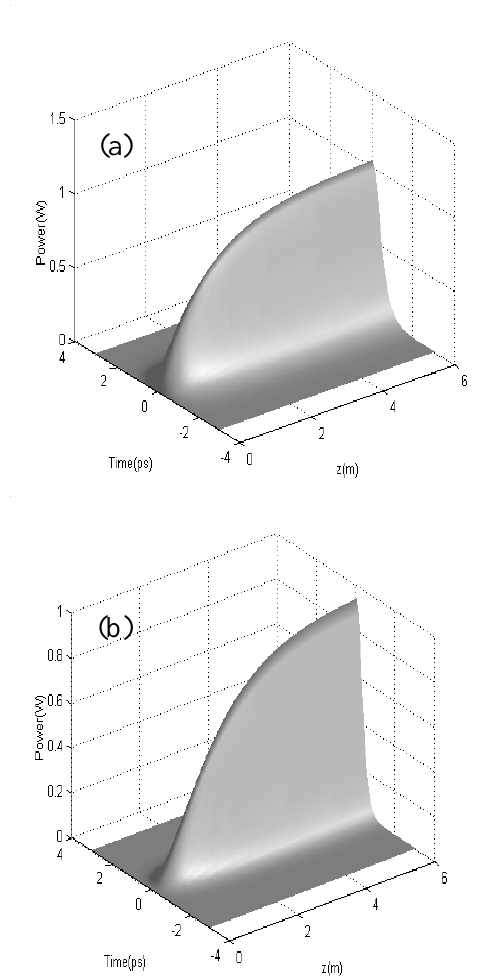
Fig.9: Soliton growth from